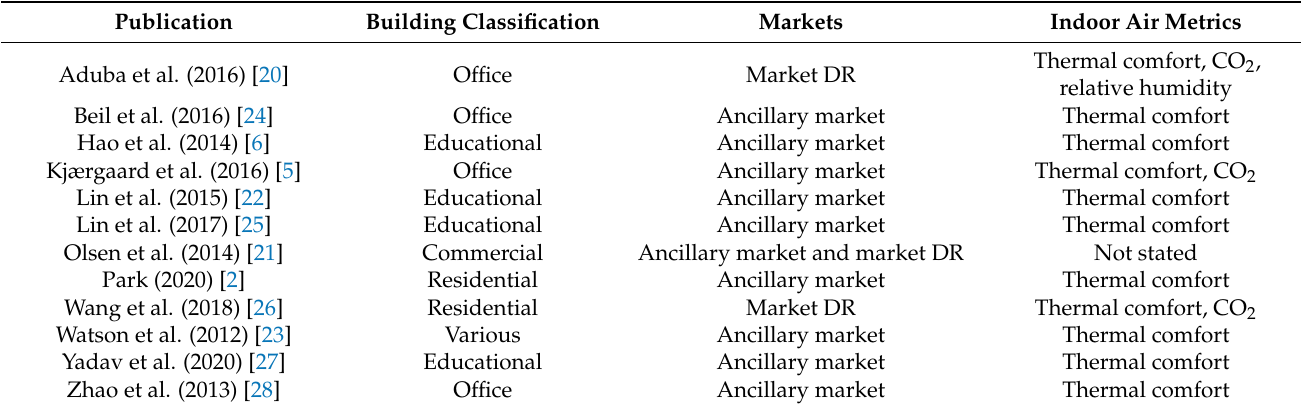
Table 1. Summary of the